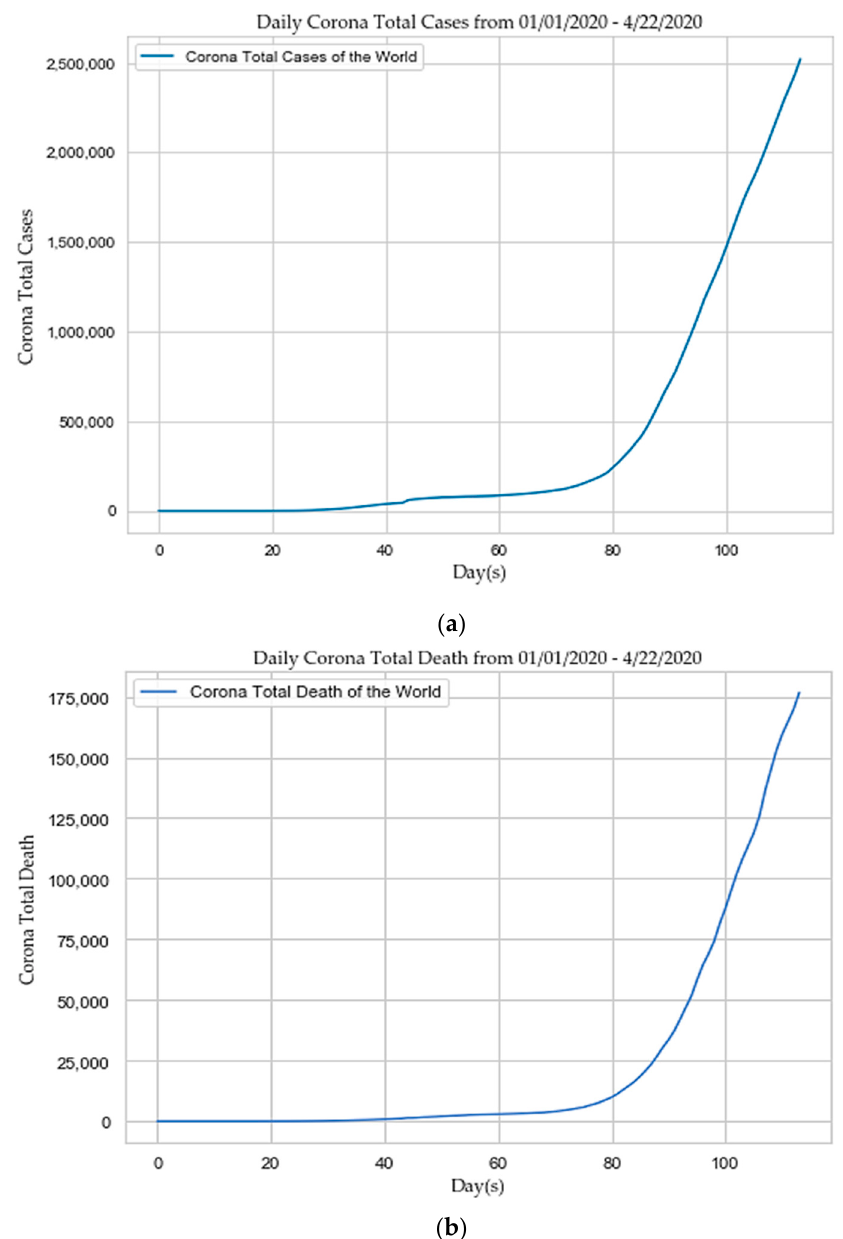
Figure 1. ( a ) Daily corona total new cases; ( b ) and daily corona total death.